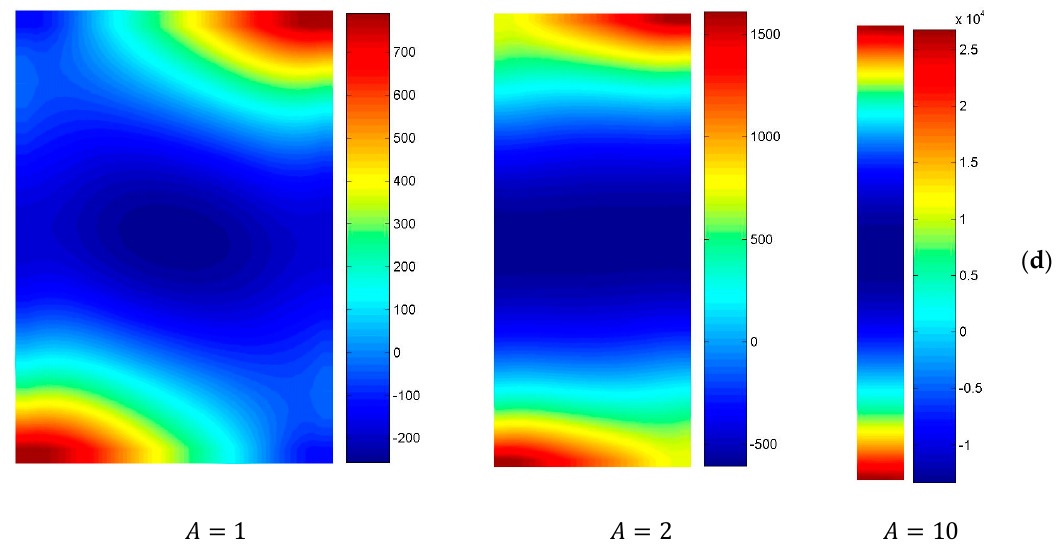
Figure 3. ( a ) Temperature fields; ( b ) velocity component u fields; ( c ) velocity component v fields; and ( d ) pressure fields; for aspect ratio equal to 1, 2, and 10, respectively.